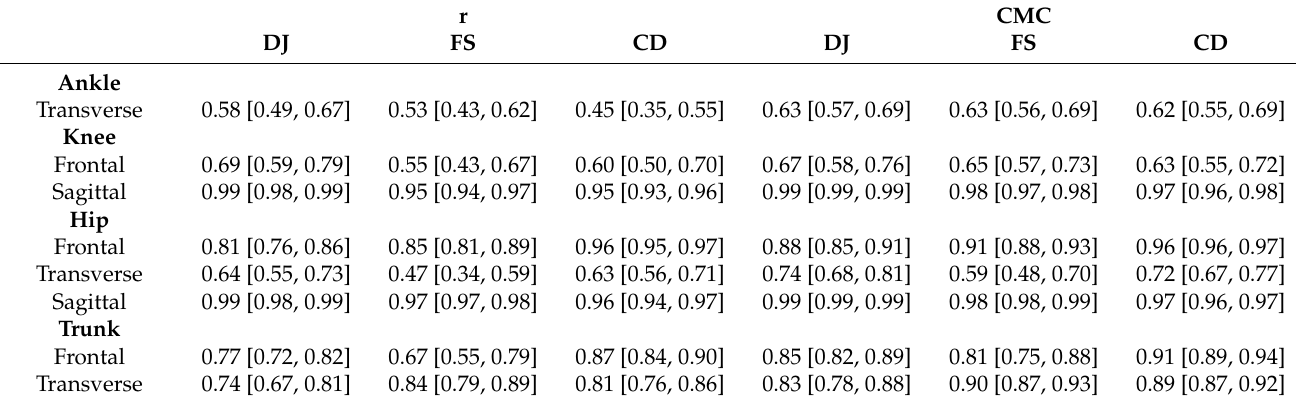
Table 2. Agreement measurements (r, CMC) between the two motion capture systems for the three motor tasks, mean [range]. r CMC